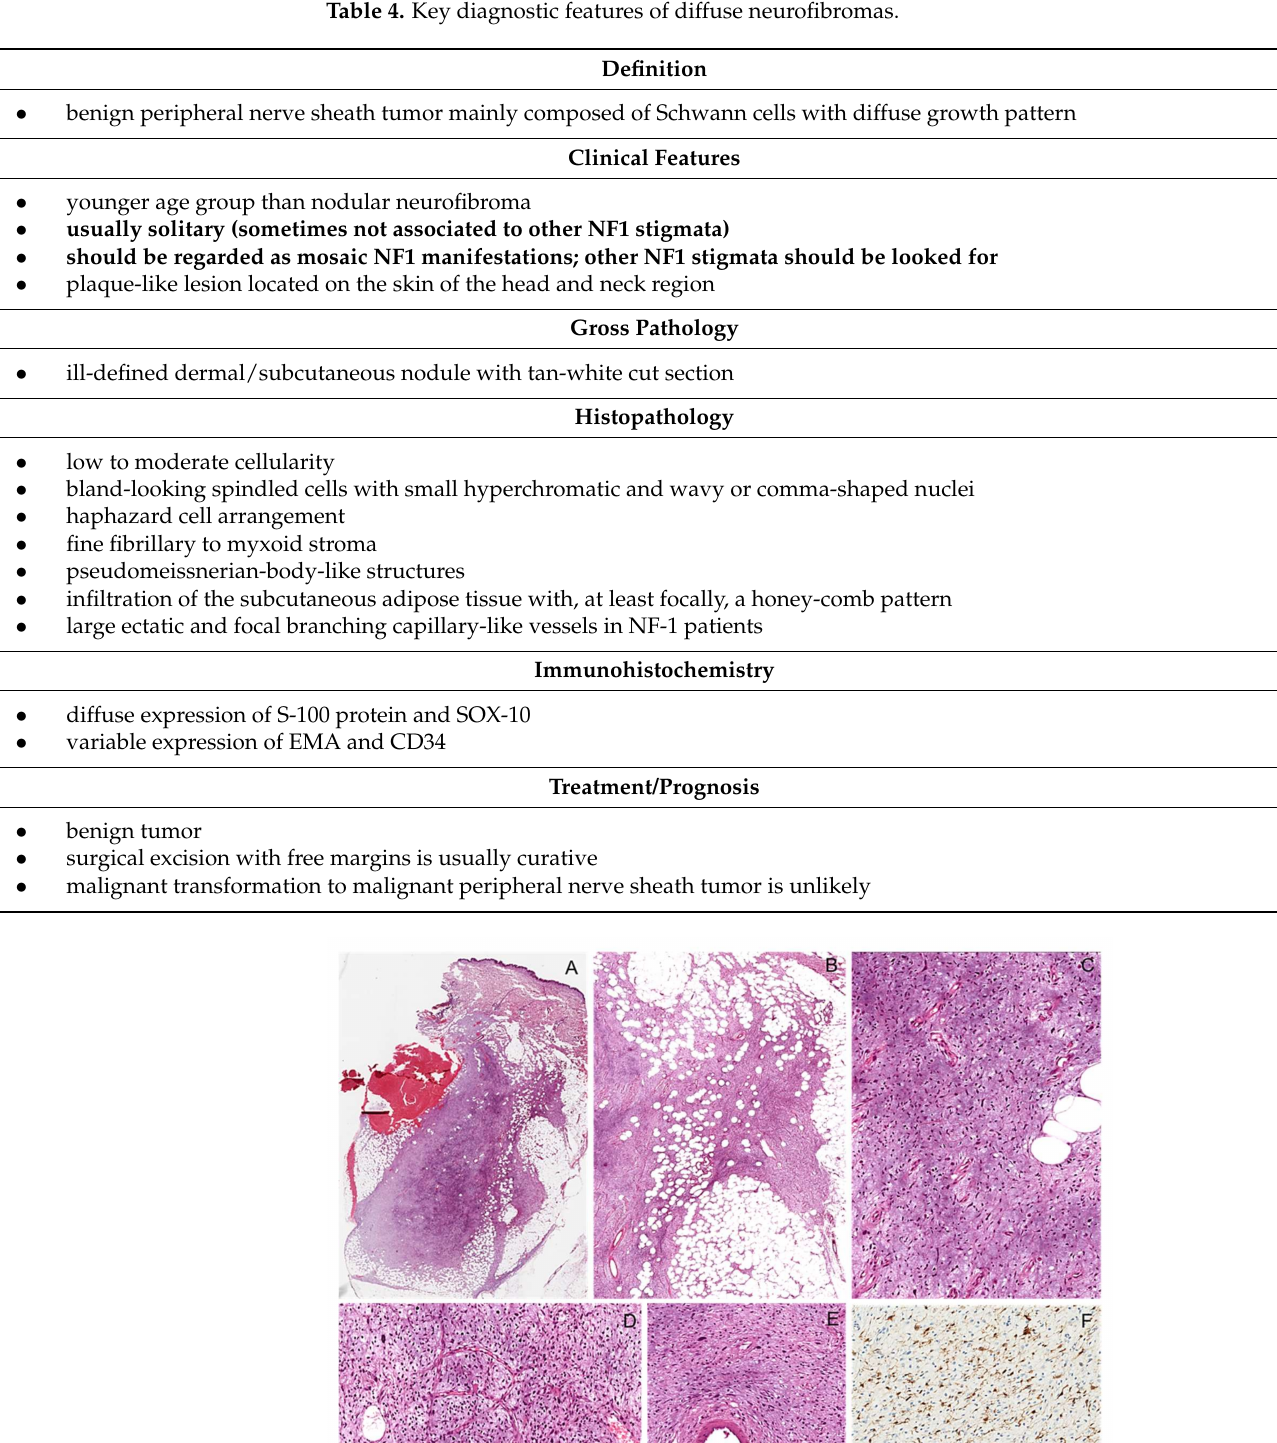
Table 4. Key diagnostic features of diffuse neurofibromas.